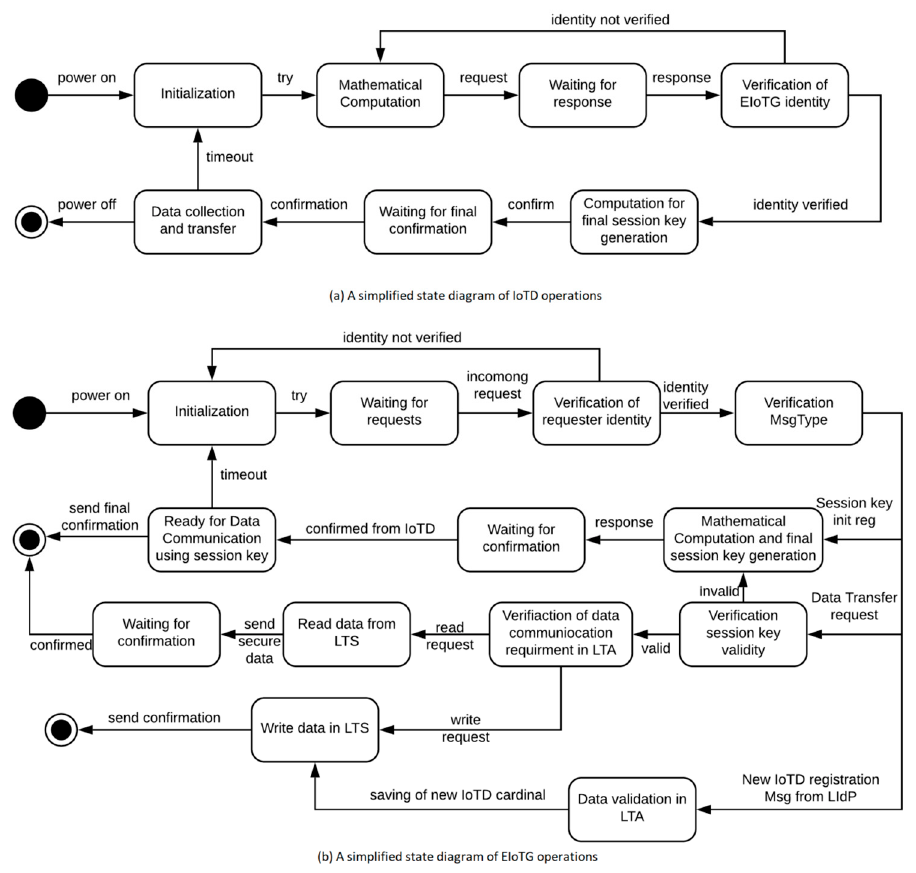
Figure 12. State diagrams of operations of IoTD and EIoTG.